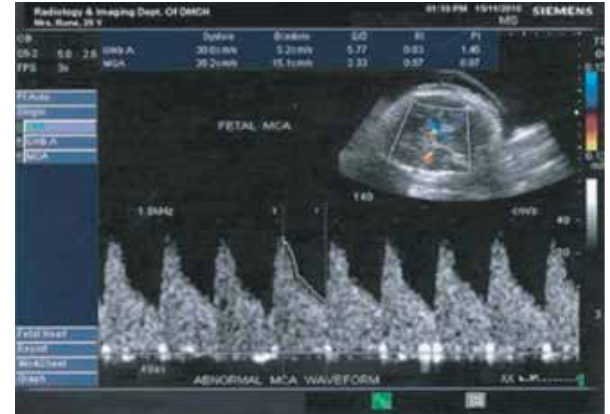
Fig 4. Abnormal middle cerebral artery waveform pattern showing low resistance and high diastolic flow due to cerebral pattern shows low impedence and high diastolic flow with a low pulsatility index. During normal pregnancy, the MCA shows high resistance and low diastolic flow with an increase in the pulsatility index.